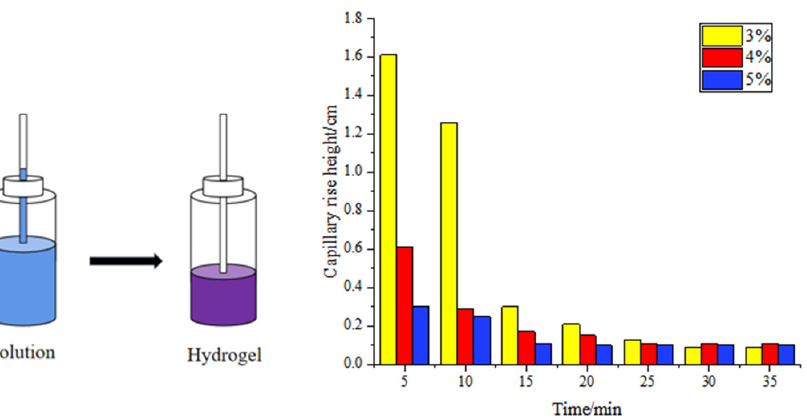
Figure 3. Schematic diagram of the capillary measurement gel formation and Sol–gel transition properties characterized by capillary measurement.